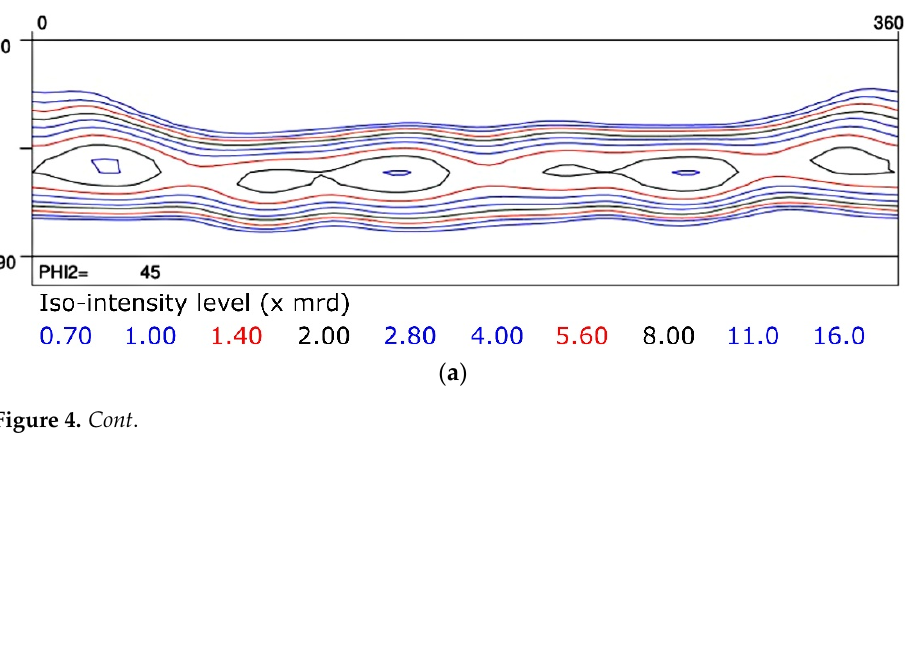
Figure 3. ( a ) Simulated FCC β fiber texture after a rolling reduction at true strain = 2; ( b ) the modeled BCC product texture without variant selection and ( c ) with double YKS variant selection.